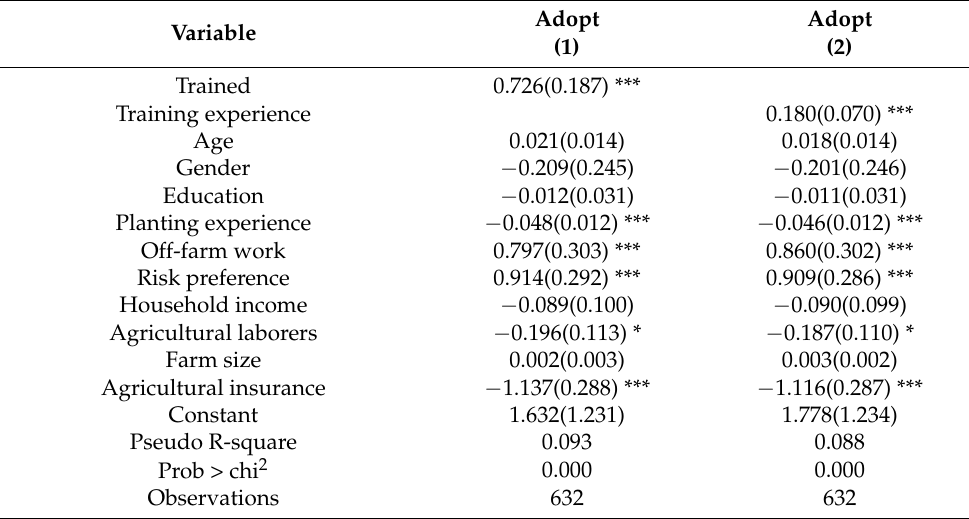
Table 5. Impact of agricultural training on the banana farmers’ adoption of the DFS.